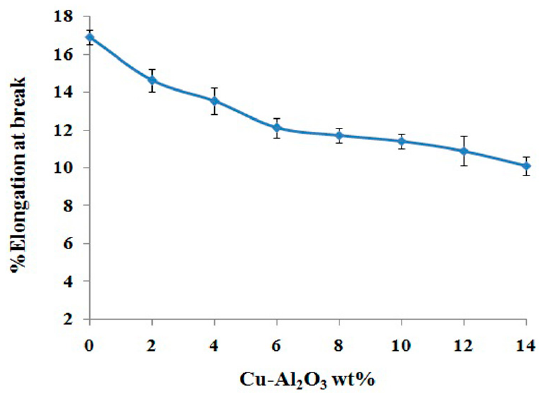
Figure 10. Elongation at break of Cu–Al 2 O 3 /PS- b -(PE- r -B)- b -PS- g -MA composites.